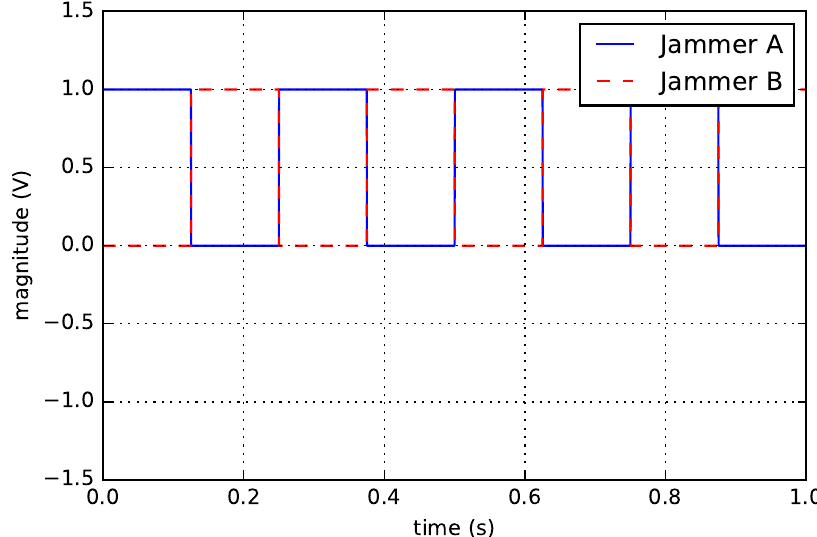
Figure 19. The jammer amplitude modulation waveforms from sources A and B operating at a 4 Hz blink and 180 ◦ out of phase.